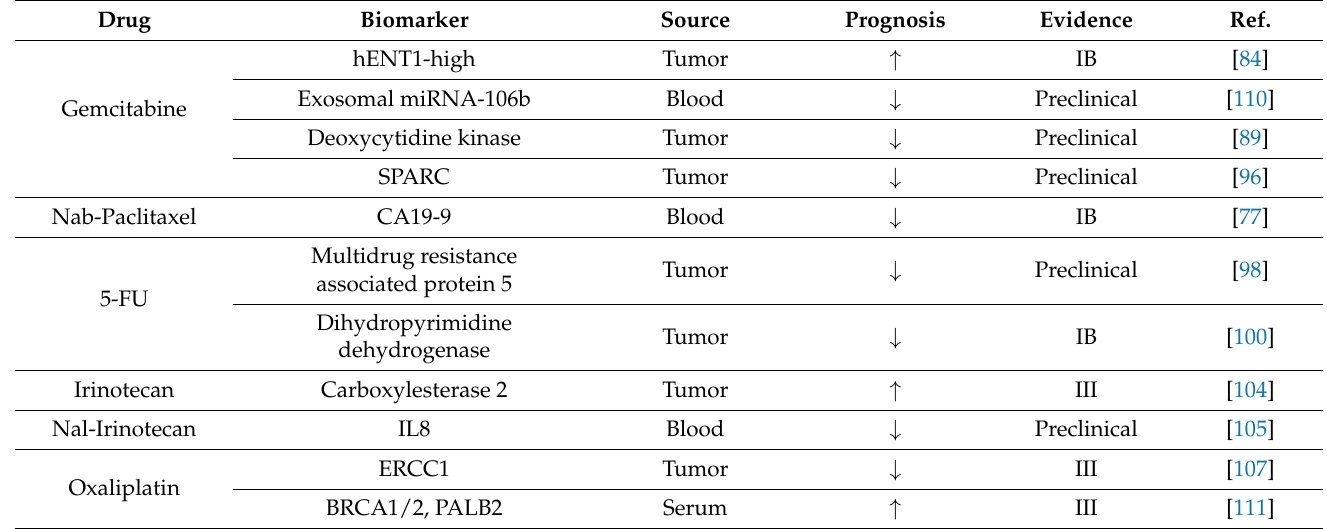
Table 1. Biomarkers as predictors for therapy response to specific cytostatic